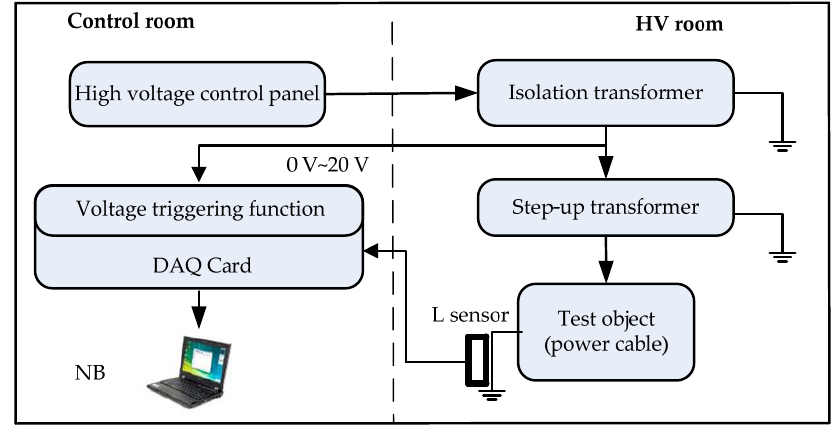
Figure 5. Block diagram of partial discharge (PD) measurement experiment.